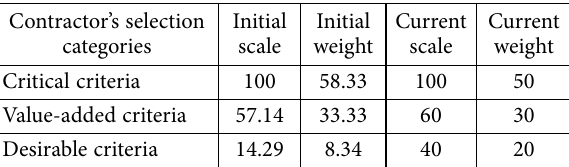
Table 4. Initial and current weights of